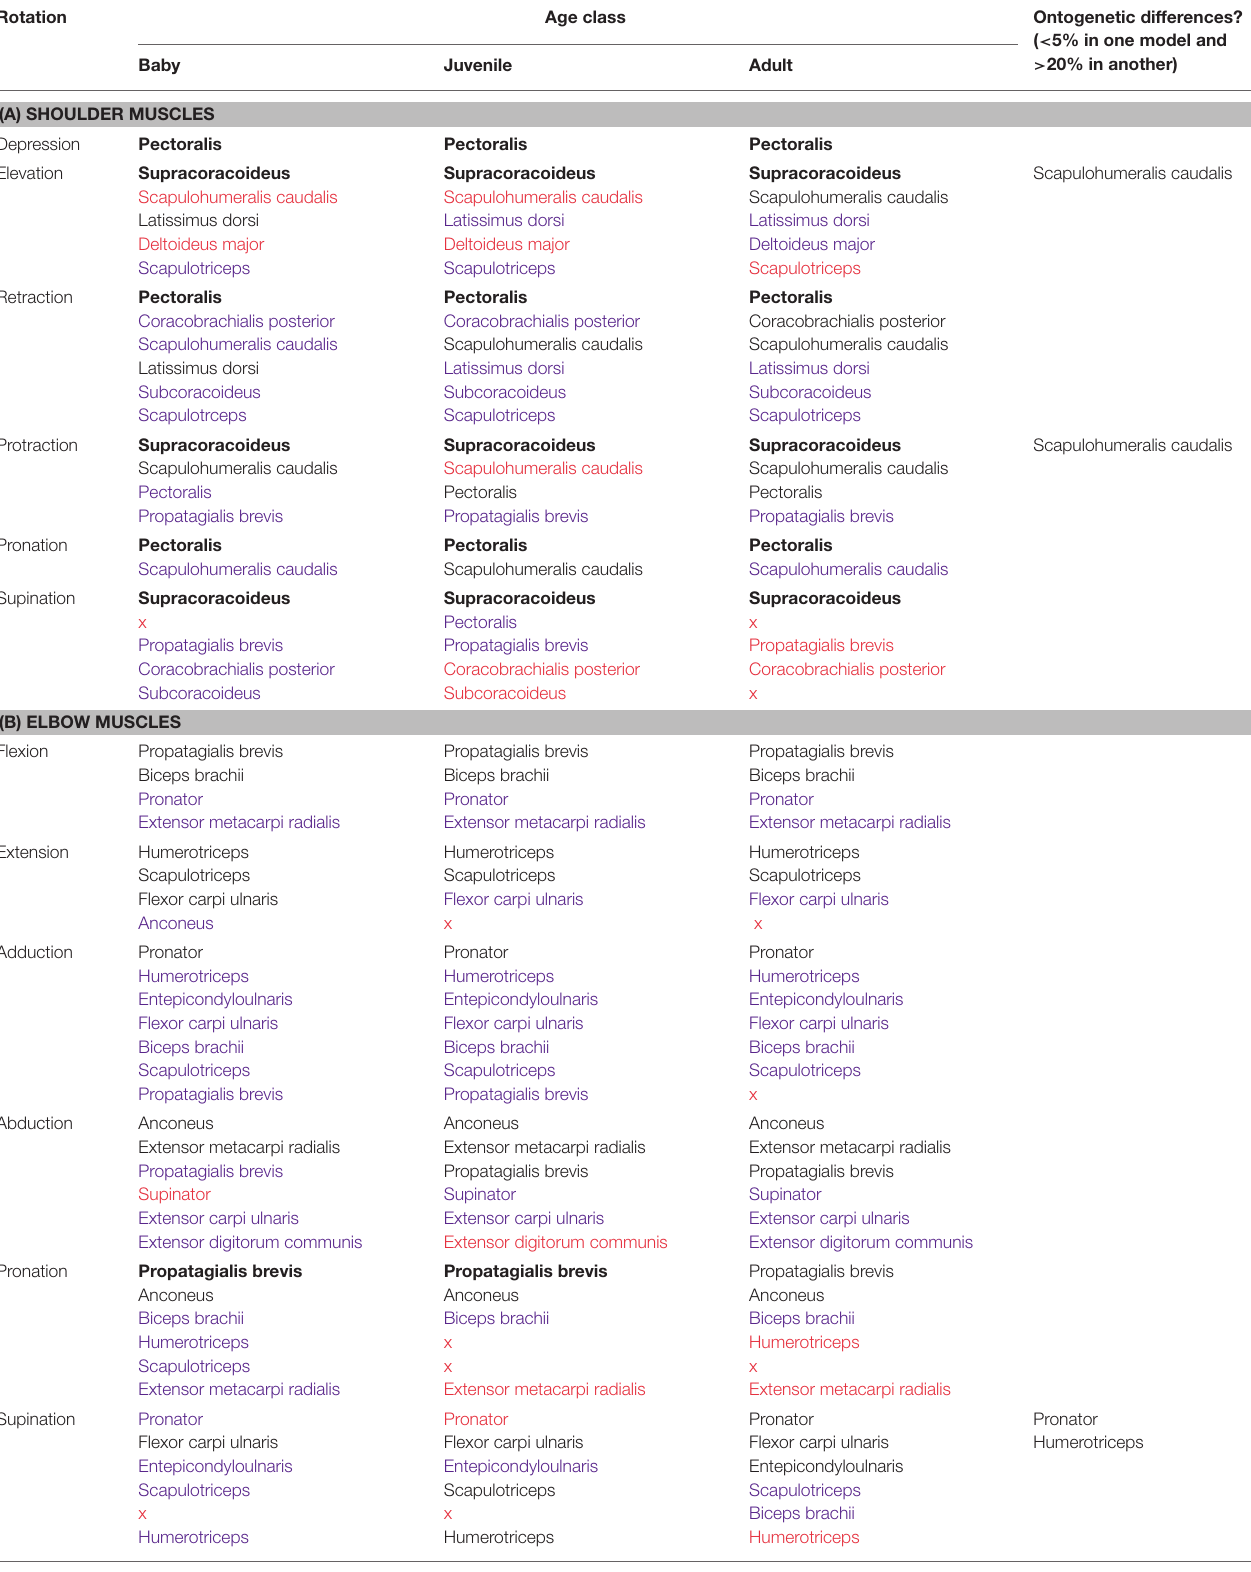
TABLE 2 | (A–C) Muscle moment arms and potential functions.